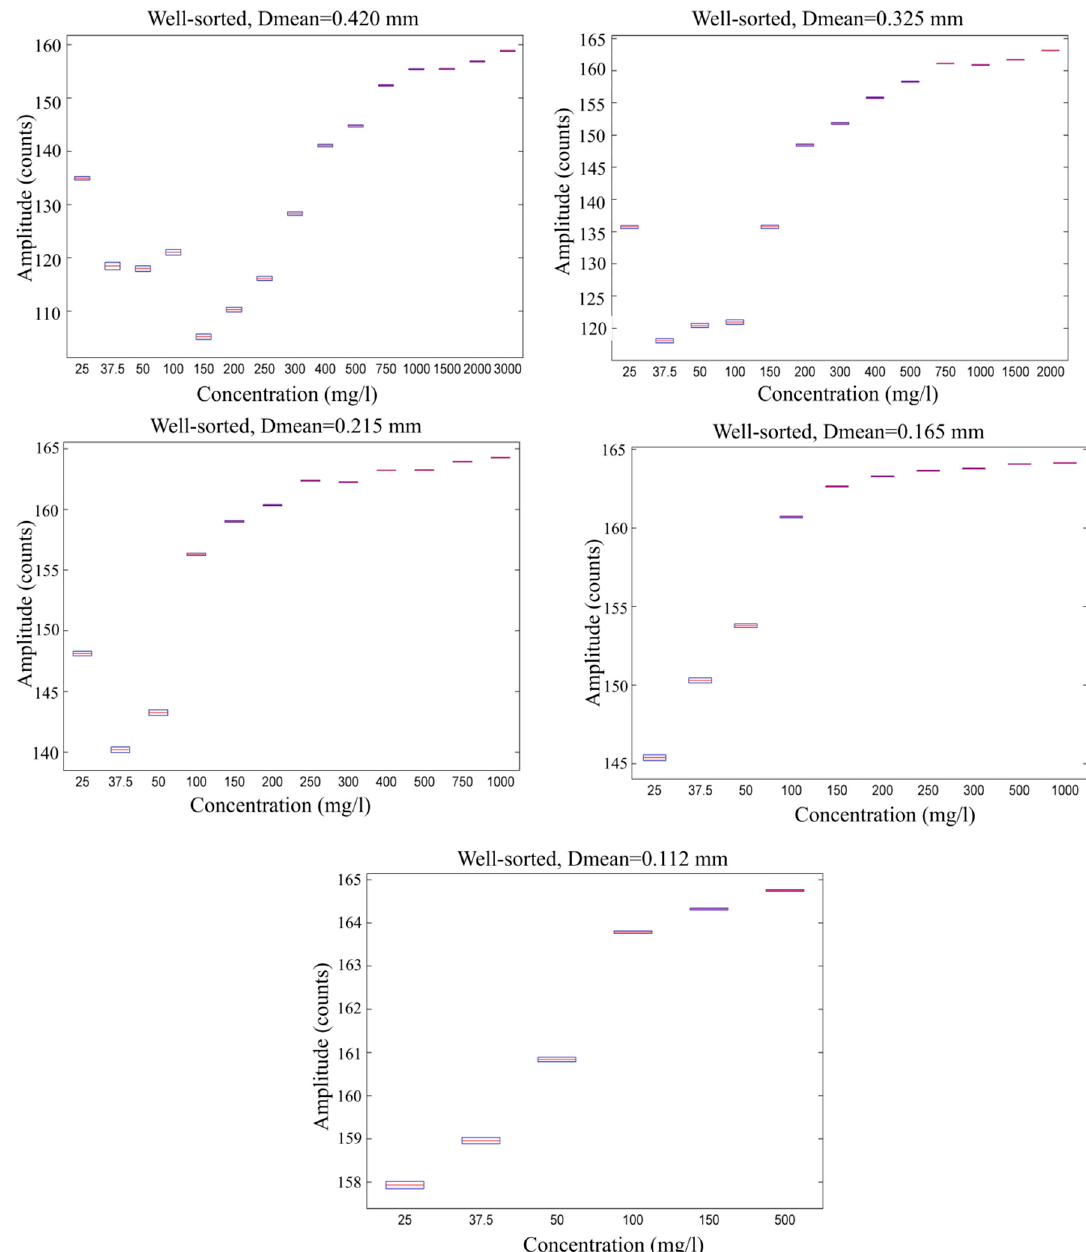
Figure 4. Raw backscatter vs. concentration for five well-sorted sand cases. The boxes show median value and 95% confidence intervals, with each scenario represented by six trials.